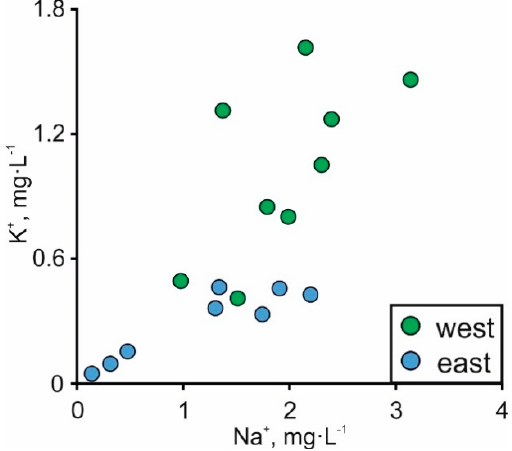
Figure 10. Na + and K + variations in streams.